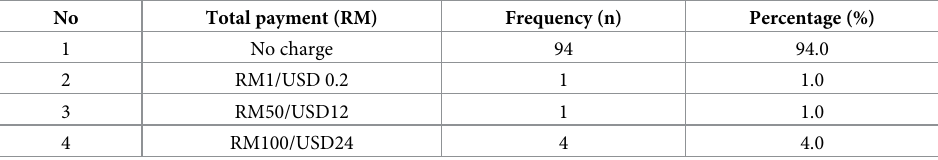
Table 5. Total payment received during wet